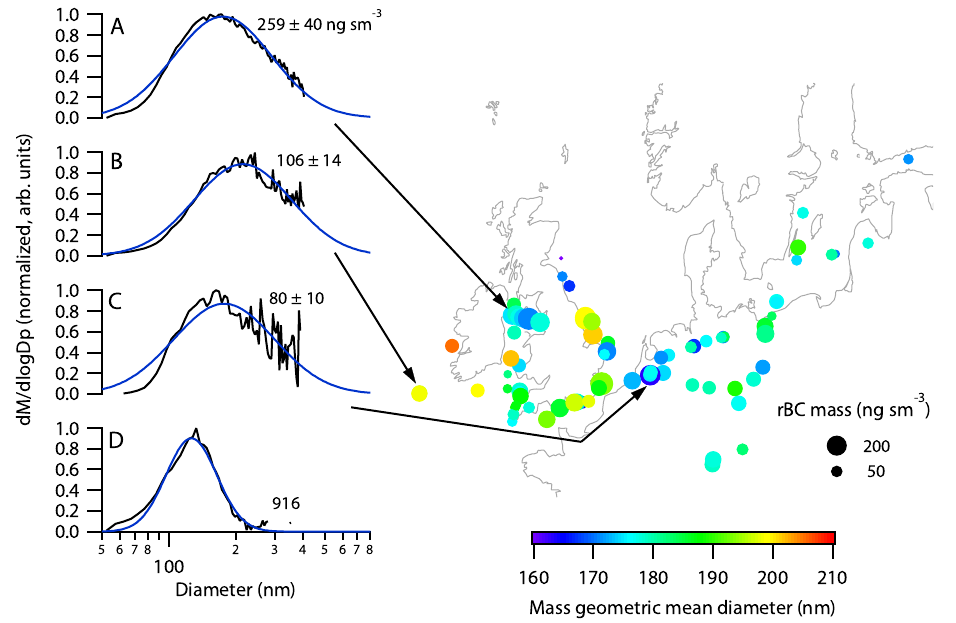
Fig. 9. Map showing refractory black carbon (rBC) mass concentrations and geometric mean diameters averaged over straight and level runs (SLRs) below 3km. Points are scaled by rBC mass concentration and shaded by geometric mean diameter. Mass distributions (dM/dlogDp), normalized by their peak value and averaged in three different regions ( a–c , indicated by black arrows) are also shown. A fourth mass size distribution (d) shows the rBC distribution measured on the ground at the aircraft base in close proximity to ground power units and other aircraft. rBC mass concentrations for each mass distribution are also shown.